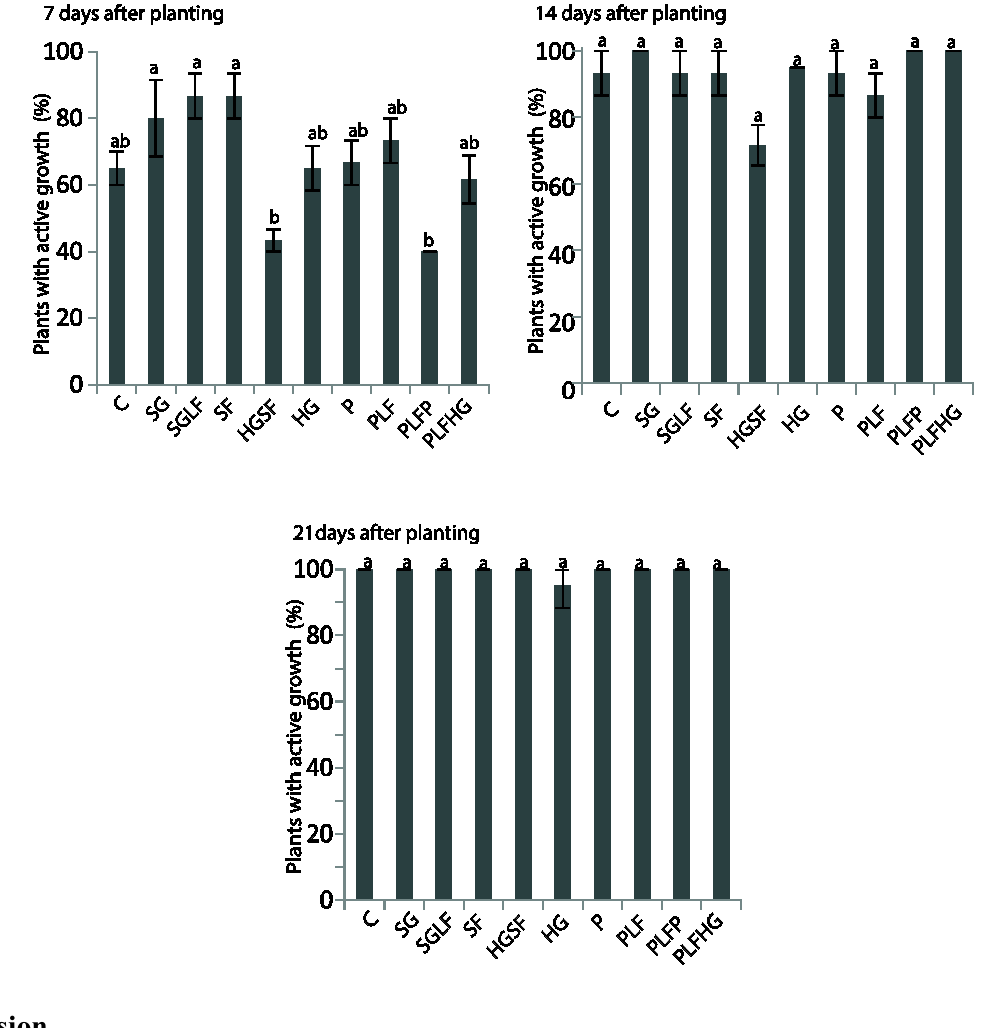
(Figure 3b,c). To summarize, initially, HGSF and PLFP coated cuttings developed slower compared to the SG, SGLF and SF treated cuttings but not to any of the other treatments. However three weeks after planting, none of the treatments resulted in a significantly faster or slower plant development. Figure 3. Timing of bud break of P. trichocarpa cuttings planted at the silty loam soil site after treatments with fertilizers, hydrogel or a combination of substrates. Bud break was scored seven, 14 and 21 days after planting according to two different developmental criteria: closed bud and actively growing shoot. The treatments consisted of no treatment (C), starch gel (SG), starch gel containing liquid fertilizer (SGLF), solid fertilizer (SF), Hydrogel (HG), Hydrogel containing solid fertilizer (HGSF), Perlite (P), Perlite containing liquid fertilizer (PLF), Perlite containing liquid fertilizer diluted with fertilizer-free Perlite (PLFP) and Perlite containing liquid fertilizer and Hydrogel (PLFHG).Data shown are the mean percentage of plants at each developmental stage, n = 3. Means with the same letter are not significantly separated at the p = 0.05